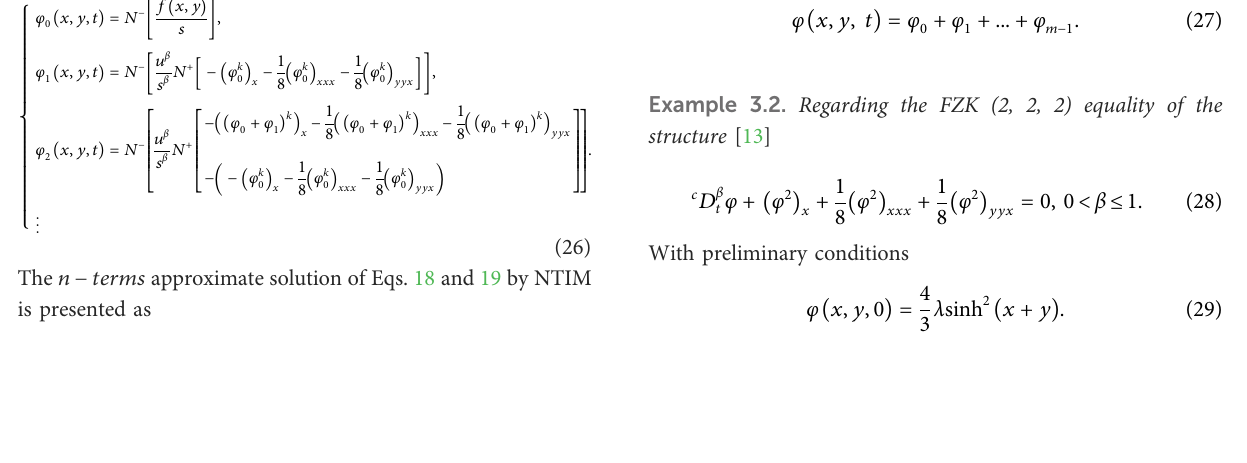
FIGURE 5 3D plots obtained by the fi rst order (A) NTIM and (B)